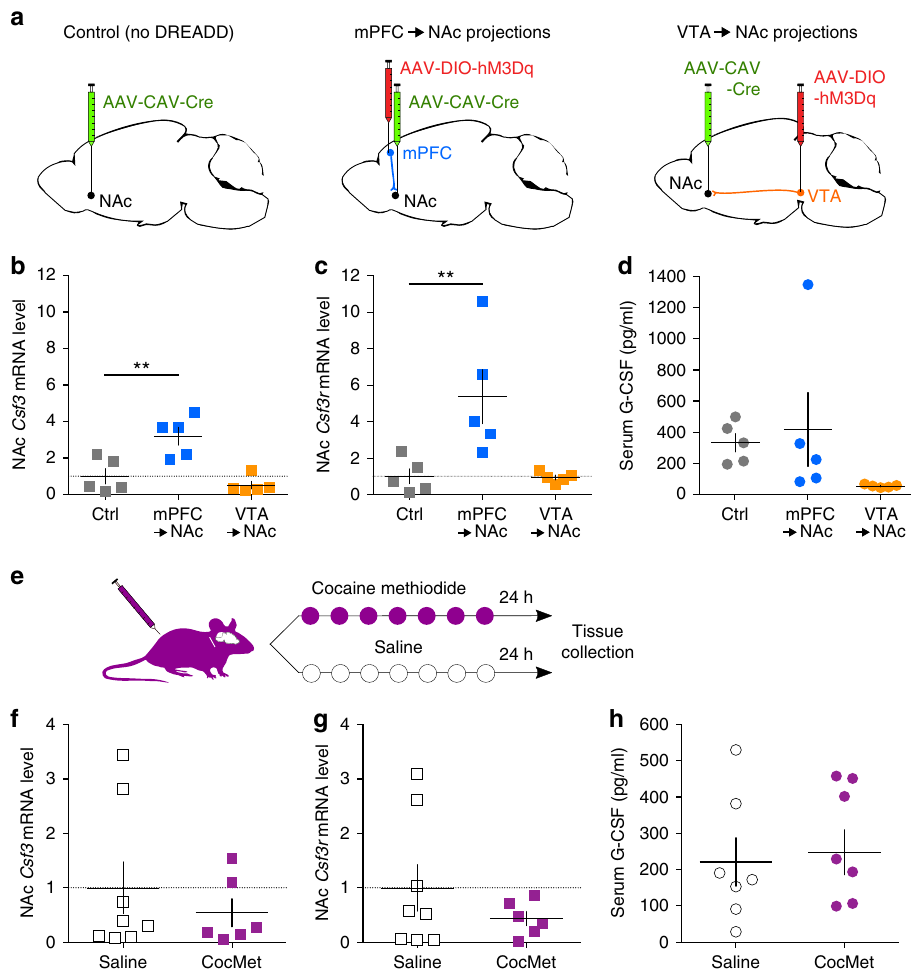
Fig. 5 G-CSF levels are increased by the selective activation of mPFC to NAc projections. a Experimental design of projection-speci fi c DREADD stimulation. Mice were injected with a retrograde traveling CAV2-Cre virus in the NAc and a Cre-dependent hM3Dq-DREADD virus in either the mPFC or the VTA to allow for the speci fi c stimulation of either mPFC to NAc or VTA to NAc. b Csf3 (G-CSF) mRNA levels in the NAc were increased after mPFC to NAc stimulation (one-way ANOVA; F (2,12) = 13.4, p = 0.0009, Sidak post-hoc: p = 0.0037 vs control). c Csf3r (G-CSFR) mRNA levels in the NAc were increased only after mPFC to NAc stimulation (F (2,12) = 8.14, p = 0.0058, p = 0.0093 vs control). d Peripheral G-CSF serum levels were not affected by stimulation (F (2,12) = 1.82, p = 0.20). e Mice were injected i.p. for 7 days with cocaine methiodide (CocMet), a cocaine analog that does not cross the blood brain barrier, to assess the effects of peripheral cocaine on G-CSF. Cocaine methiodide chronic treatment had no effect on f Csf3 (G-CSF) mRNA levels in the NAc (two-tailed Student ’ s t -test; t (12) = 0.772, p = 0.45), g Csf3r (G-CSFR) mRNA levels in the NAc ( t (12) = 1.11, p = 0.29), or h G-CSF serum levels ( t (12) = 0.631, p = 0.54). Data represented as mean ± s.e.m. (** p < 0.01 for Sidak post-hoc signi fi cant between-group difference (Fig. 7a; two-tailed Student ’ s t -test: t (13) = 1.48, p = 0.16). However, given that cocaine treat- ment bolsters G-CSF expression in the NAc (Fig. 3), we wanted to test the possibility that the signal needed to be neutralized more